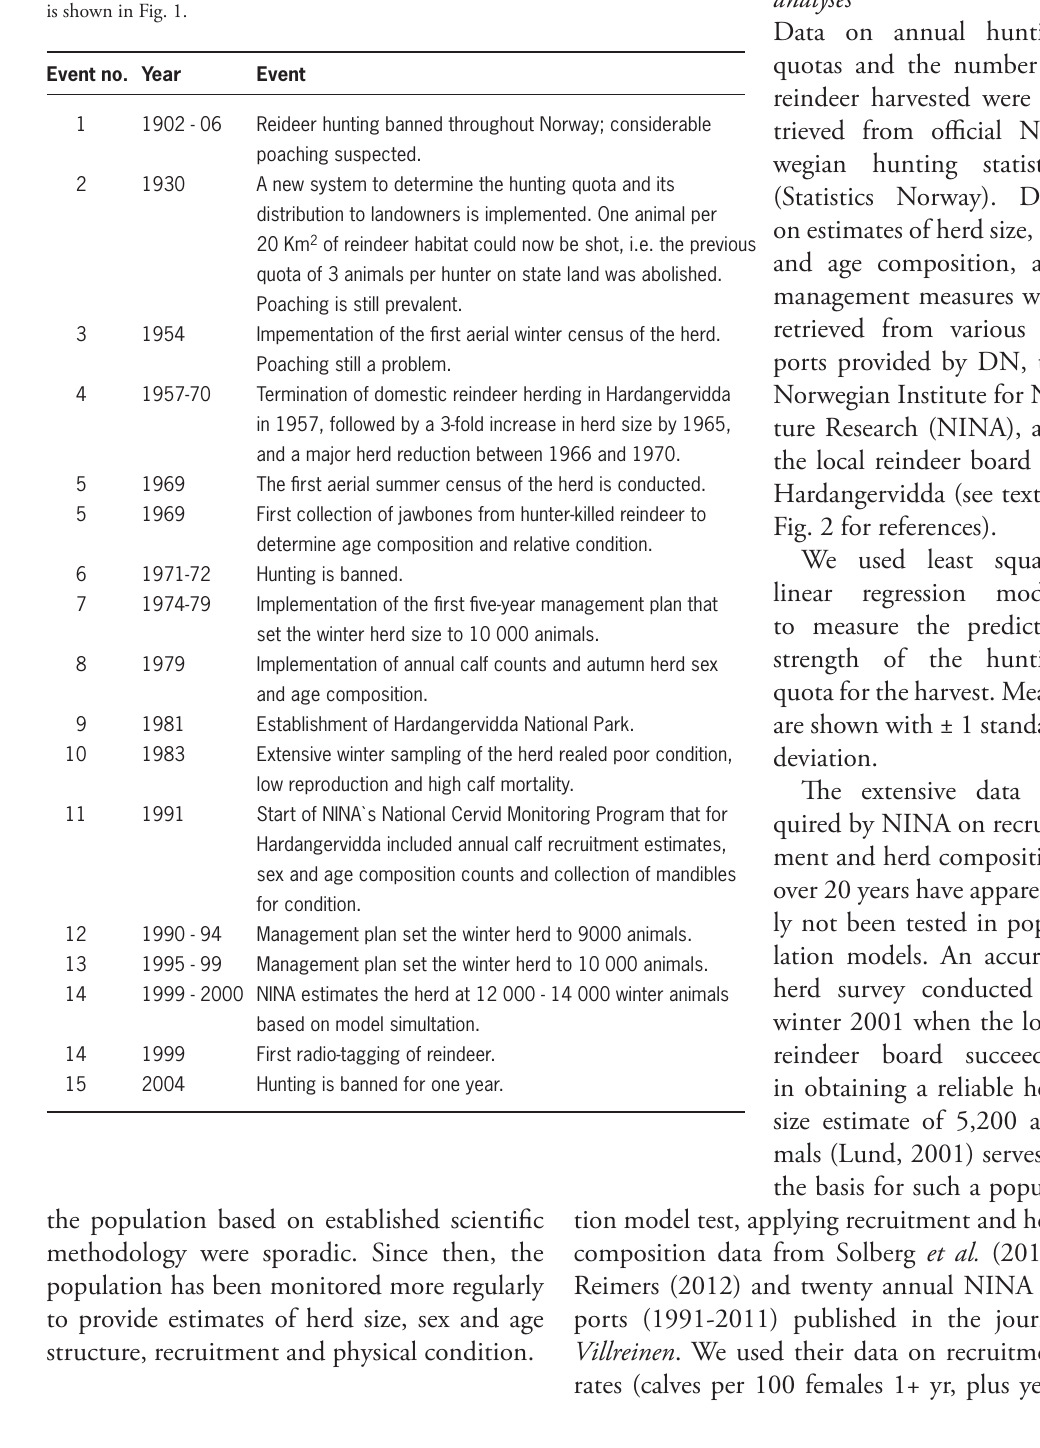
Table 1. Summary of events that have had an impact on the size and management of the Hardangervidda wild reindeer herd from 1902 – 2012. The point in time for each event is shown in Fig.